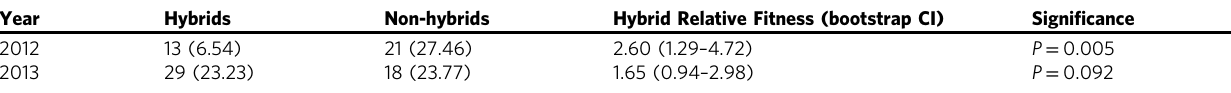
Table 2 Number of new adult hybrids, non-hybrids and their relative fi tness